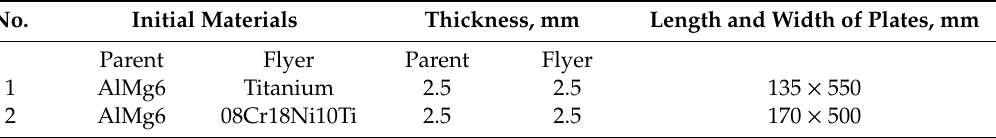
Table 2. Dimensions and thicknesses of initial